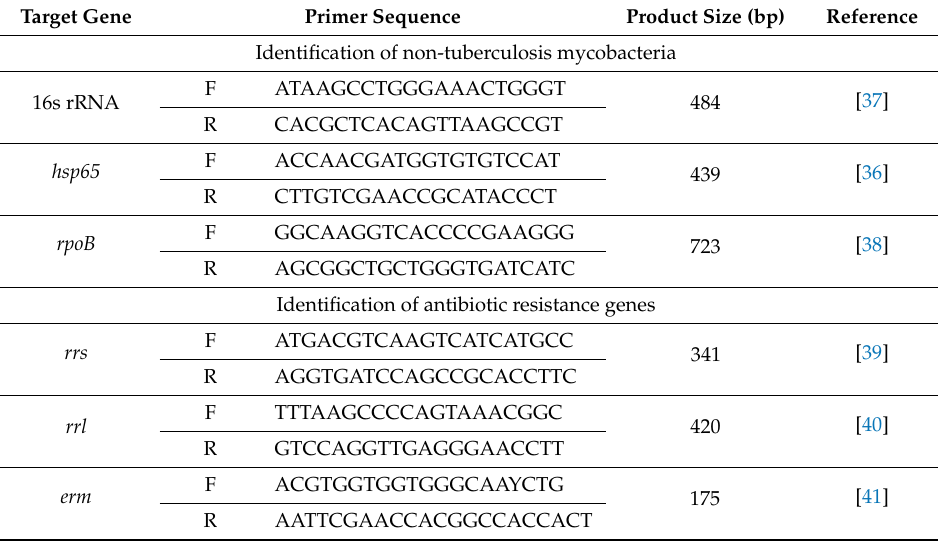
Table 1. Table 1. Nucleotide sequences of the primers used in this